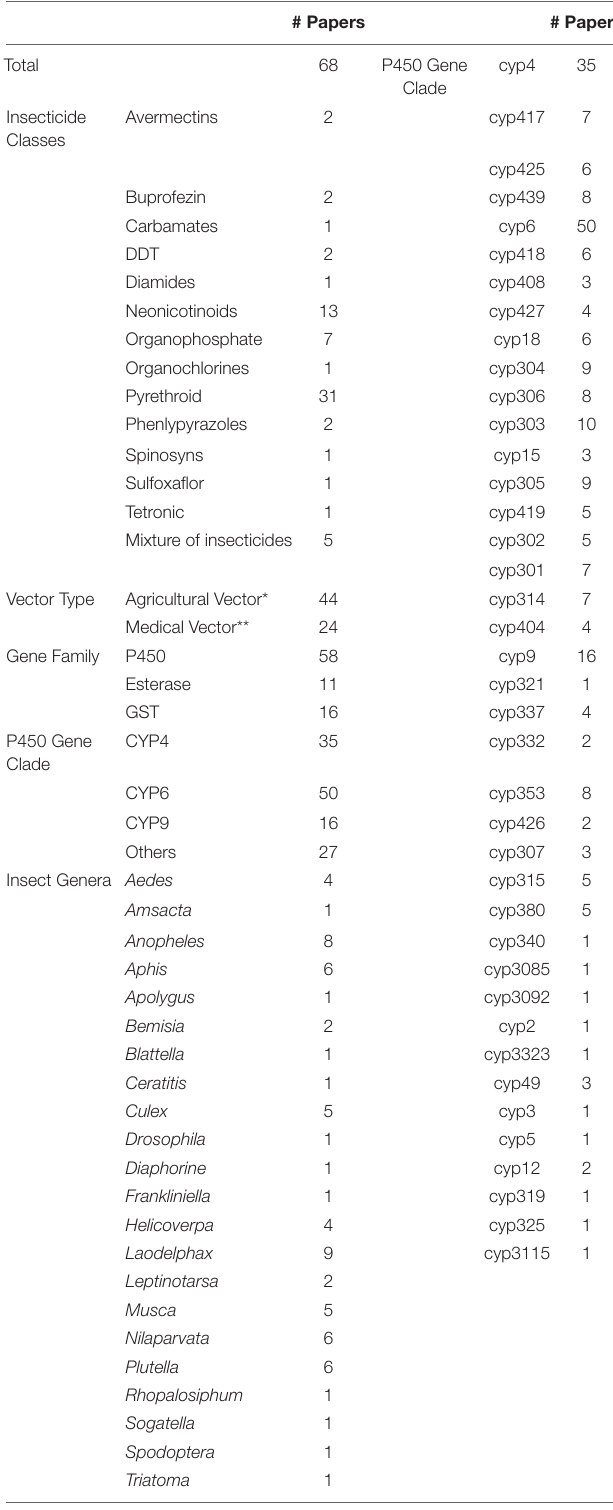
TABLE 1 | Number of studies in different